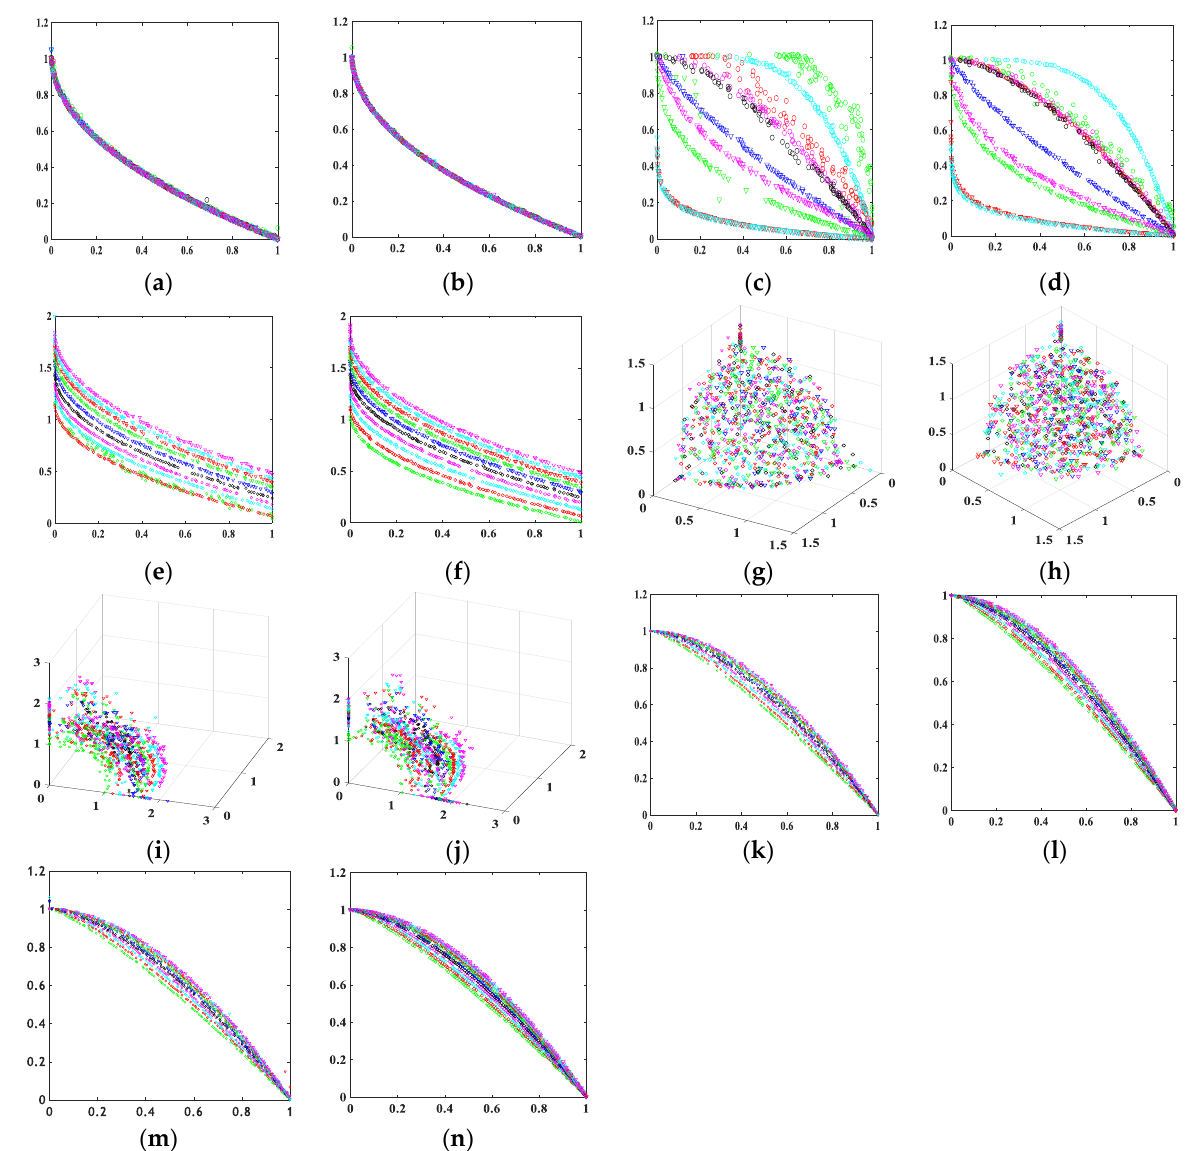
Figure 3. Simulation results on benchmarks: ( a ) POF of DVEPSO on FDA1, ( b ) POF of DEVPSO/FD on FDA1, ( c ) POF of DVEPSO on FDA2, ( d ) POF of DEVPSO/FD on FDA2, ( e ) POF of DVEPSO on FDA3, ( f ) POF of DEVPSO/FD on FDA3, ( g ) POF of DVEPSO on FDA4, ( h ) POF of DEVPSO/FD on FDA4, ( i ) POF of DVEPSO on FDA5, ( j ) POF of DEVPSO/FD on FDA5, ( k ) POF of DVEPSO on DMOP1, ( l ) POF of DEVPSO/FD on DMOP1, ( m ) POF of DVEPSO on DMOP2, and ( n ) POF of DEVPSO/FD on DMOP2.